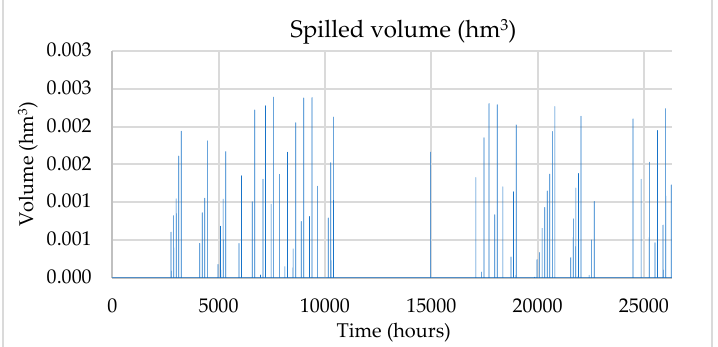
Figure 14. Behavior of the volume in the upper tank throughout the simulation, 3 years . Own source with analysis of results.